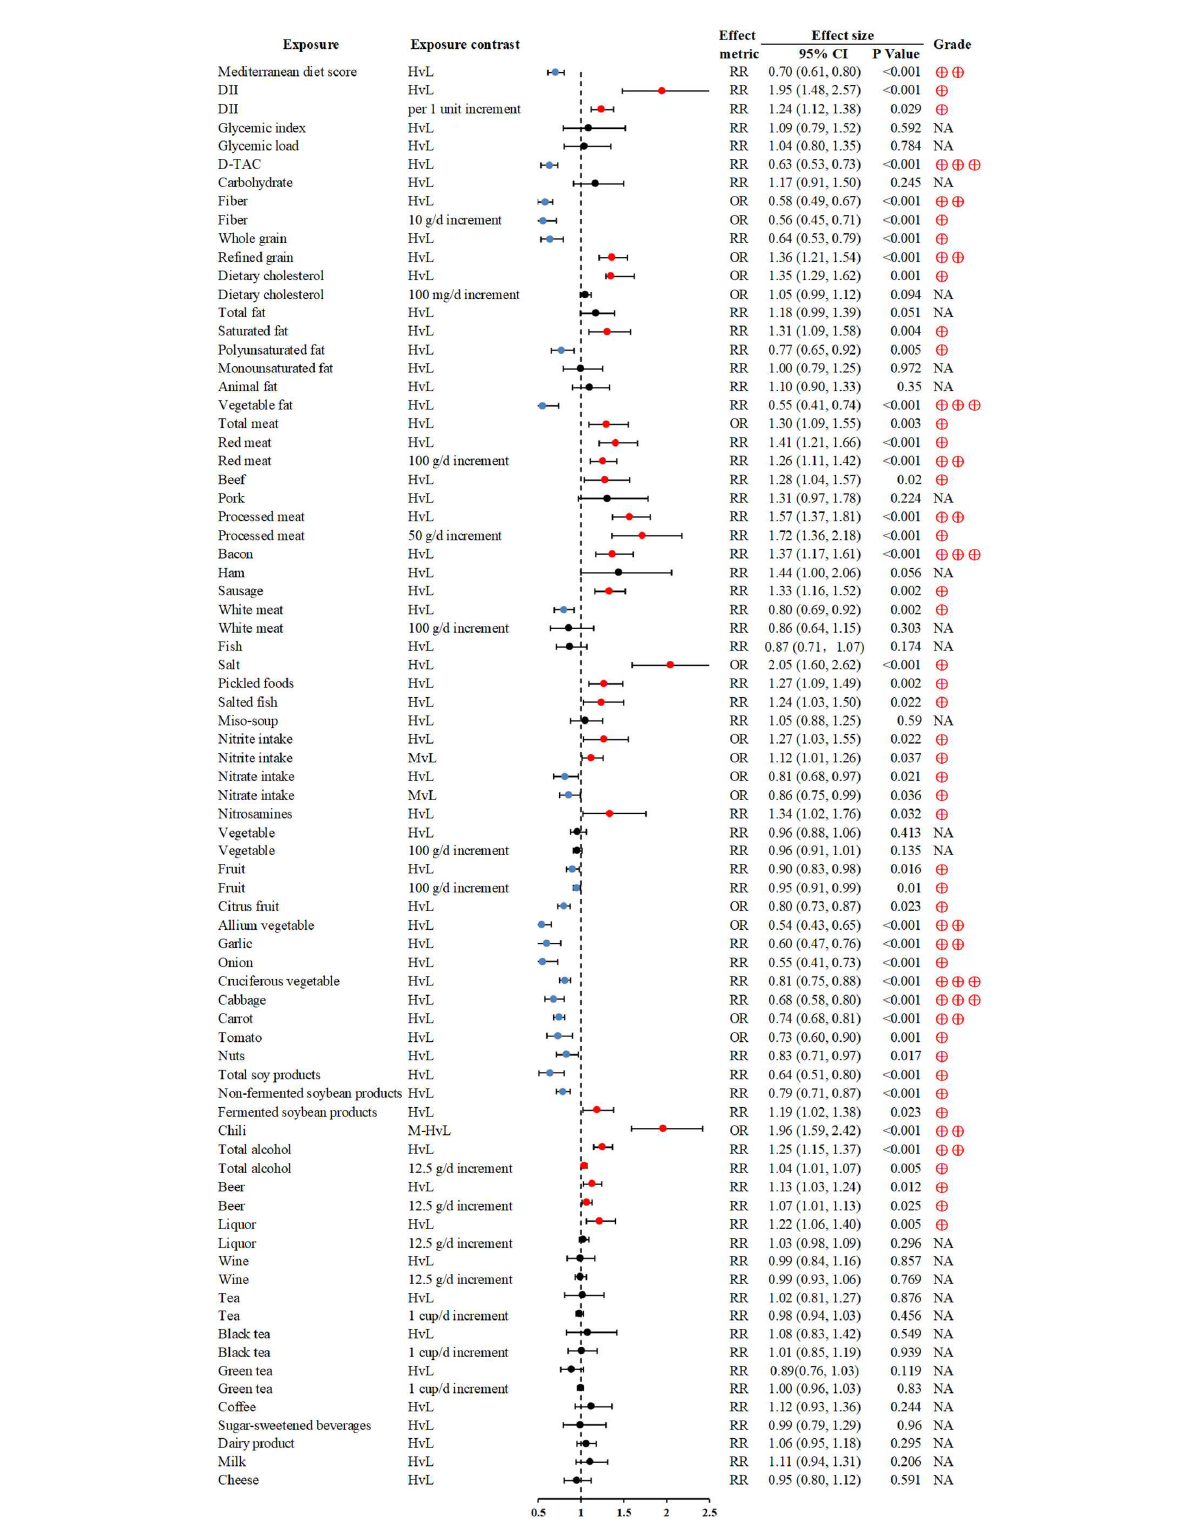
FIGURE3 Forest plot: summary effect estimates of meta-analyses reporting associations between GC and factors pertaining to dietary intake. DII, dietary inflammatory index; D-TAC, dietary total antioxidant